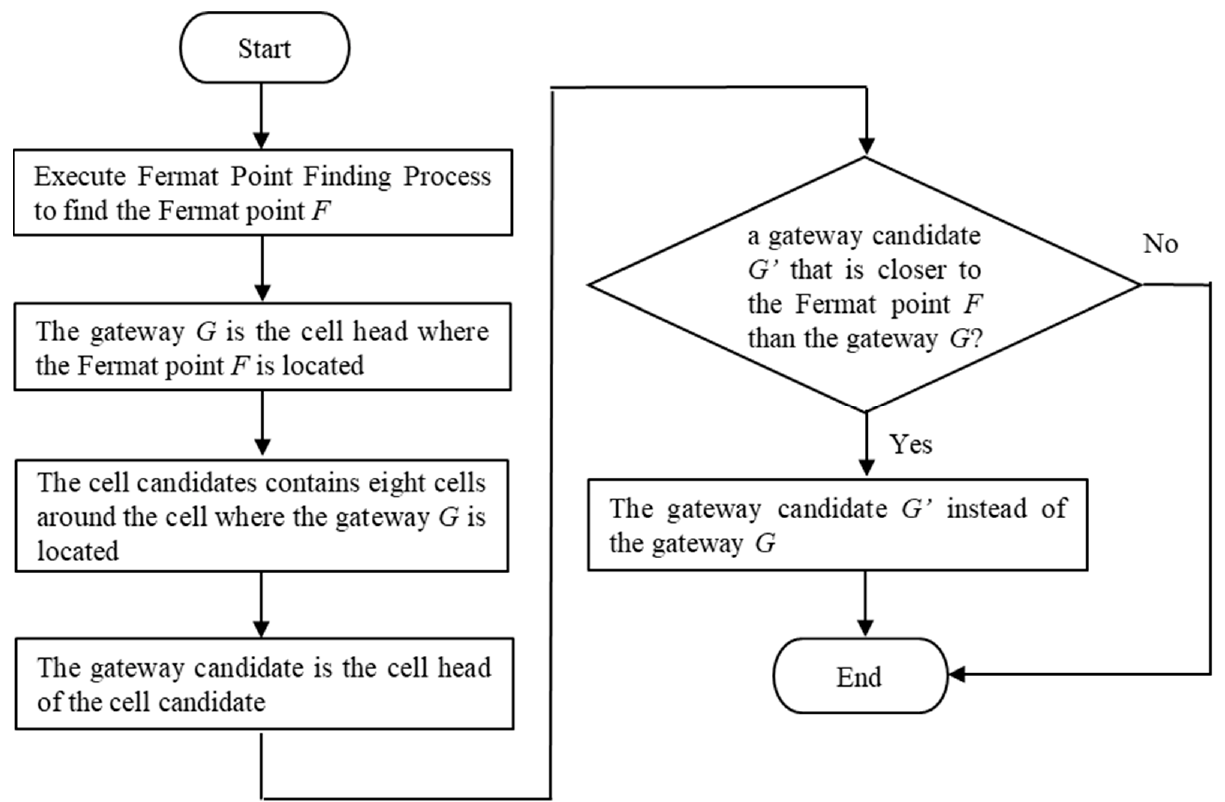
Figure 3. Flowchart of Gateway Selection Algorithm. Algorithm 2: Gateway Selection